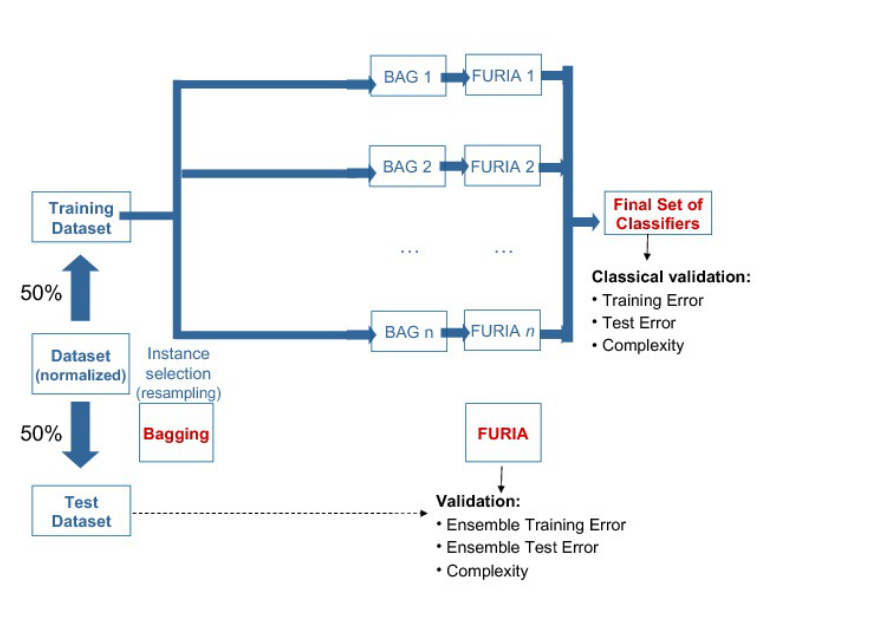
Figure 1: Our framework: after the instance and the feature selection procedures, the component classifiers are derived by the FURIA learning method. Finally, the output is obtained using a voting-based combination